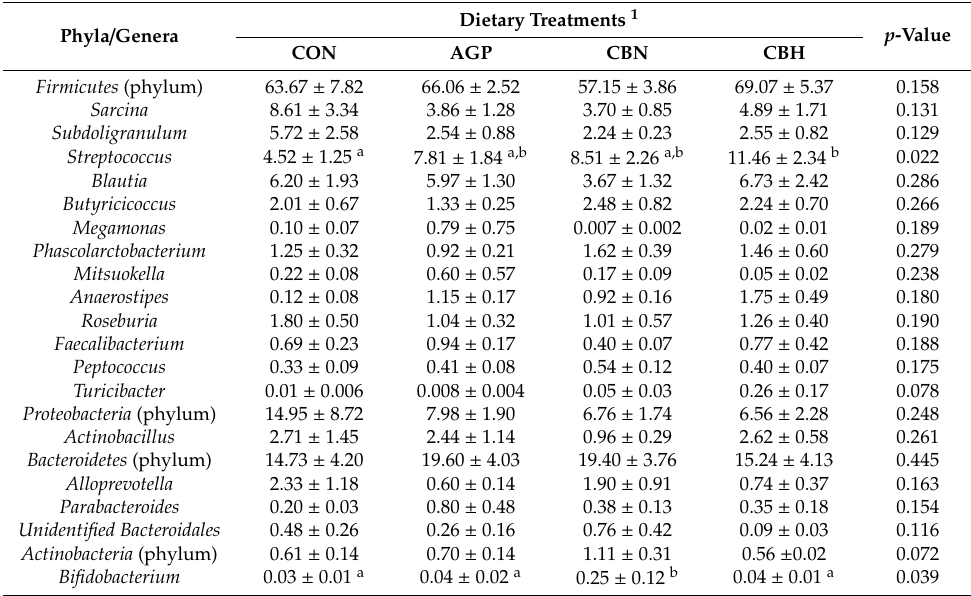
Table 7. E ff ect of dietary C. butyricum on the relative abundance (%) of microbiota in the colonic chyme of piglets (mean ± SE 2